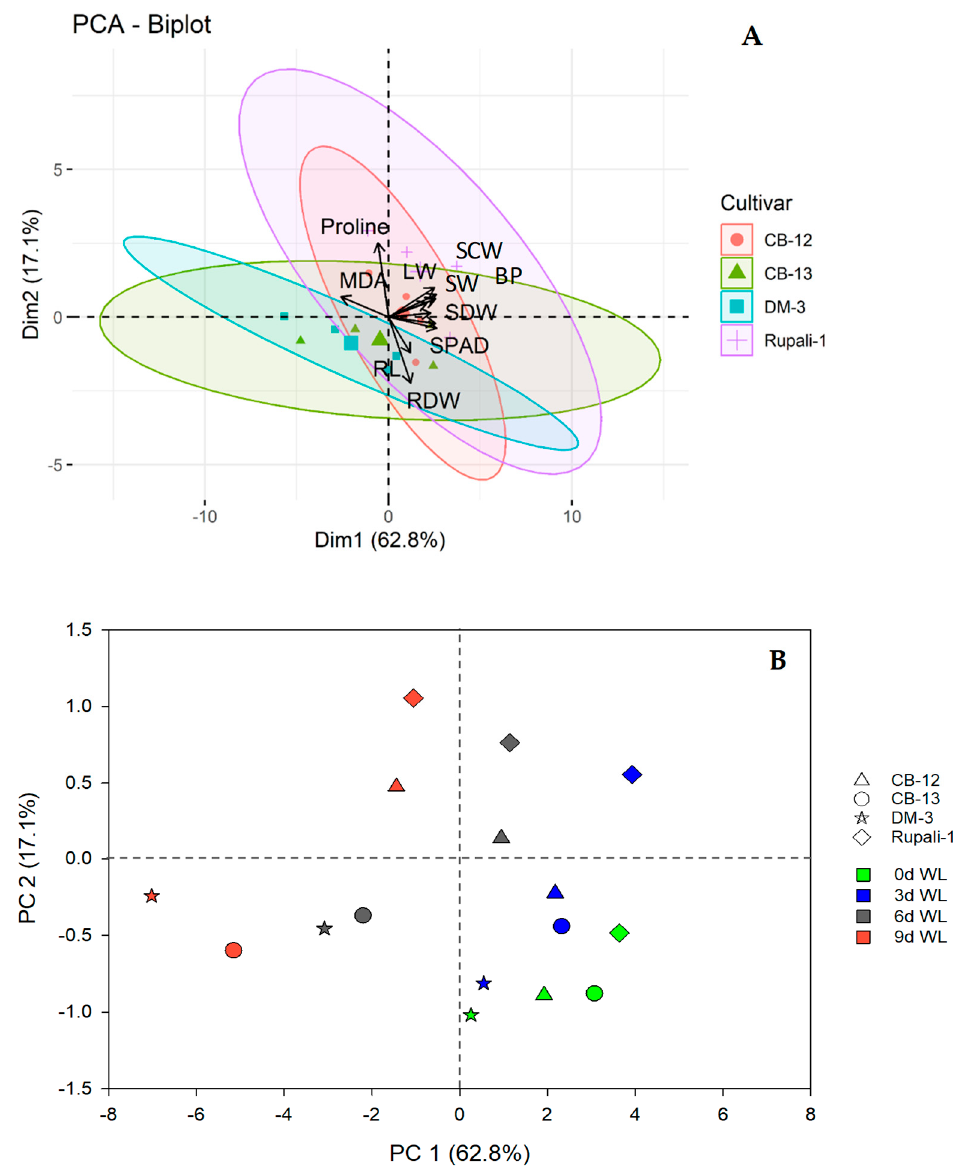
Figure 6. Principal component (PC) analysis (PCA) shows PC1 and PC2. ( A ) The bi-plot represents the relationship among the investigated traits of the four elite cotton cultivars. ( B ) The cluster shows the tolerance levels of the cotton cultivars under various WL conditions. BP, boll plant − 1 ; LW, lint weight; PH, plant height; RDW, root dry weight; RL, root length; SCW, seed cotton weight; SDW, shoot dry weight; SW, seed weight; and WL, waterlogging.